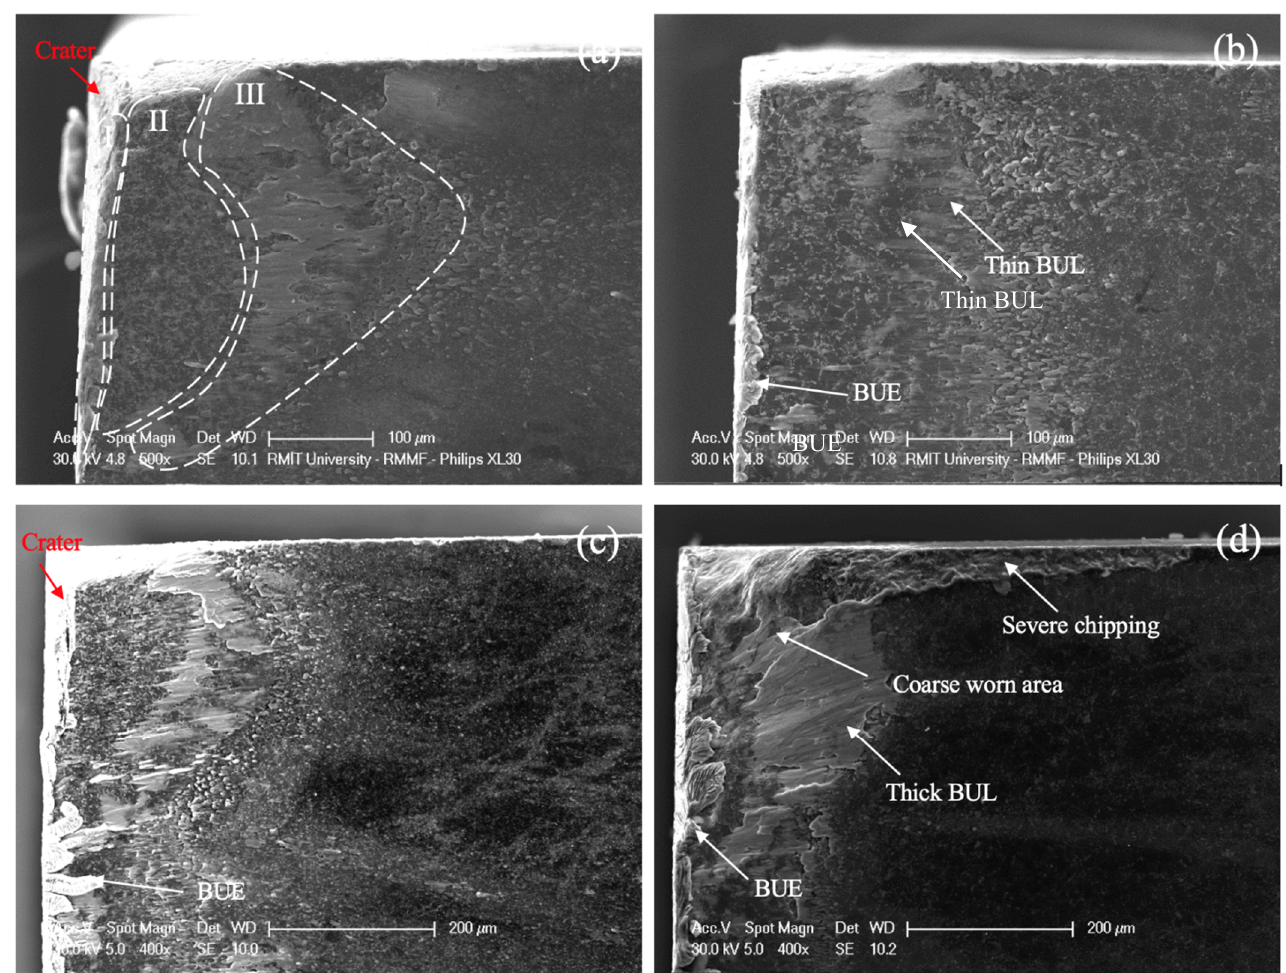
Figure 14. Crater wear after the turning experiment: ( a ) 002A ( b ) 302A ( c ) 002E ( d ) 302E.